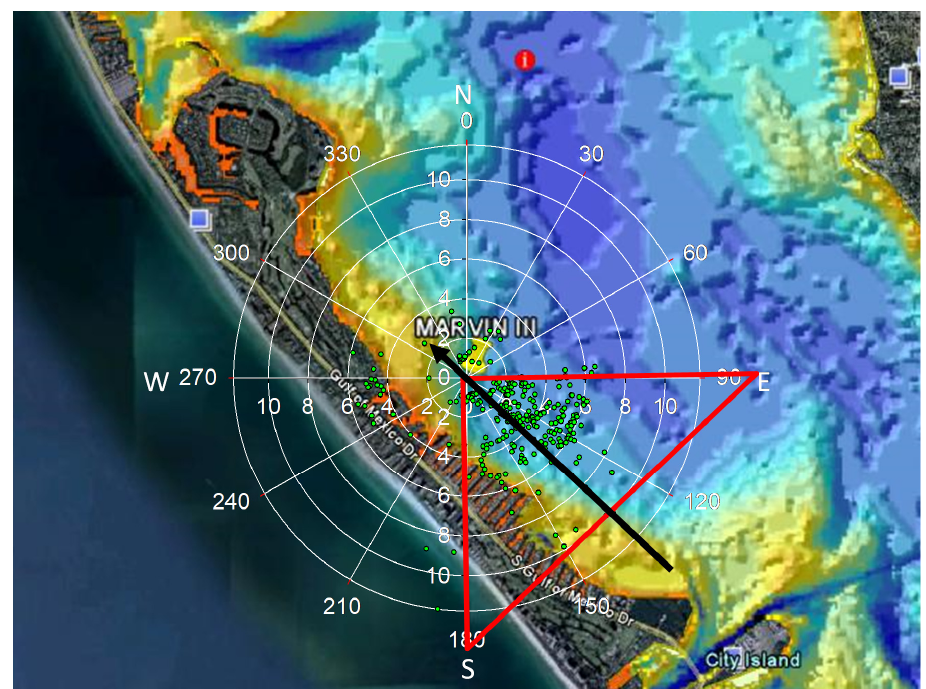
Figure 9. Compass diagram showing the urea concentration (green dots) and associated prevailing wind direction, in relation to the MARVIN platform and Sarasota Bay bathymetry during the summer and fall 2009 deployment. Quadrant of prevailing wind direction is indicated in red. Black arrow indicates a line heading of 133°. Background image, Google Earth 2009. Water 2020 , 12 , x